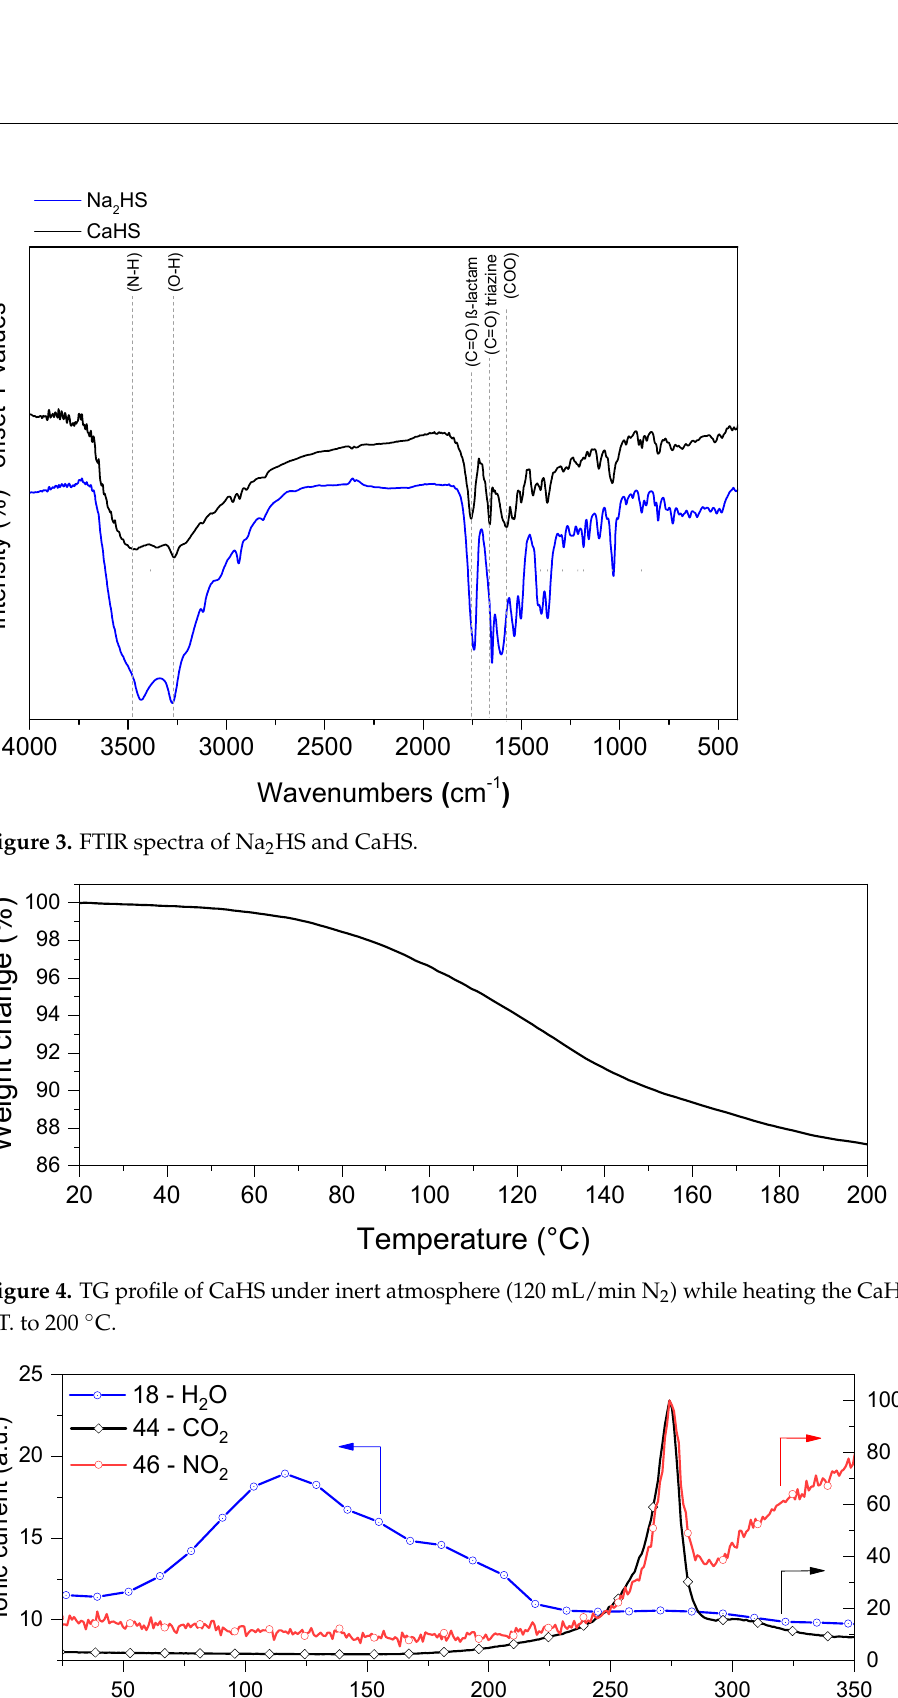
6 of 14 Figure 2 . SEM micrographs of ( a , b ) Na 2 HS and ( c , d ) CaHS with ( e ) EDX spectrum. The coordination mode of the ceftriaxone anion towards Ca 2+ was determined by comparing the FTIR spectra of Na 2 HS and CaHS (Figure 3). After the complexation of ceftriaxone to the Ca 2+ ion, the frequencies of both of the stretching vibrations of the carbonyl groups of β -lactam ((C=O) β -lactam) and triazine ((C=O) triazine) are shifted towards higher values, thus implying the involvement of the oxygen atoms in the coordination towards the Ca 2+ ion. A shift towards higher wavenumbers at 3480 cm − 1 is also observable for the band at 3427 cm − 1 assigned to the (N − H) stretching vibration of the NH 2 group, supporting the hypothesis that the nitrogen atom of the amino group coordinates with the metal ion. The carboxylate group (COO) peak is shifted towards